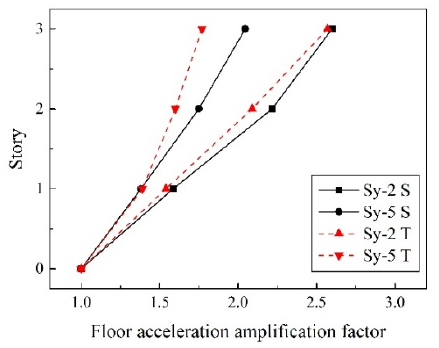
Figure 9. Comparison of FAA under different conditions.